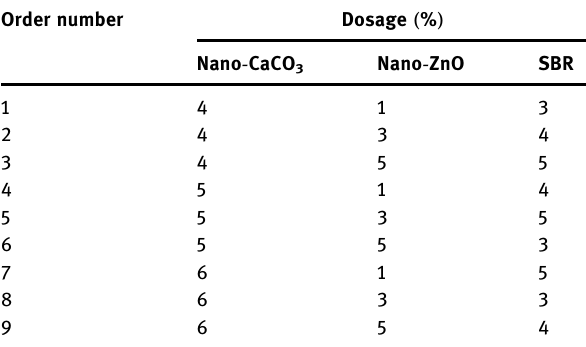
Table 5: The dosage combination of each modi fi er Order number Dosage ( %